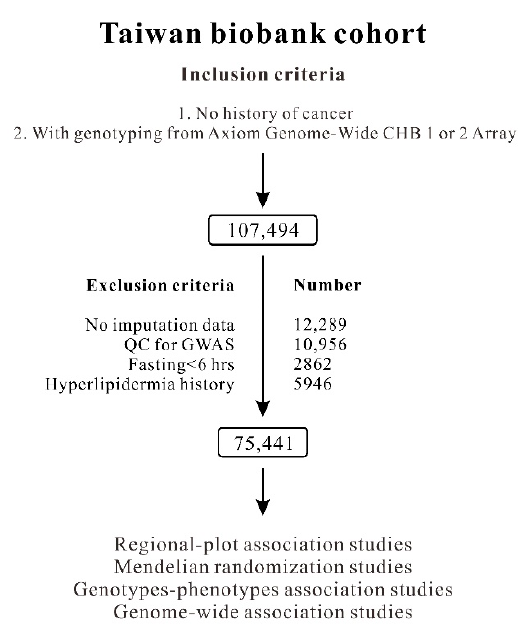
Figure 1. Participant selection flowchart.